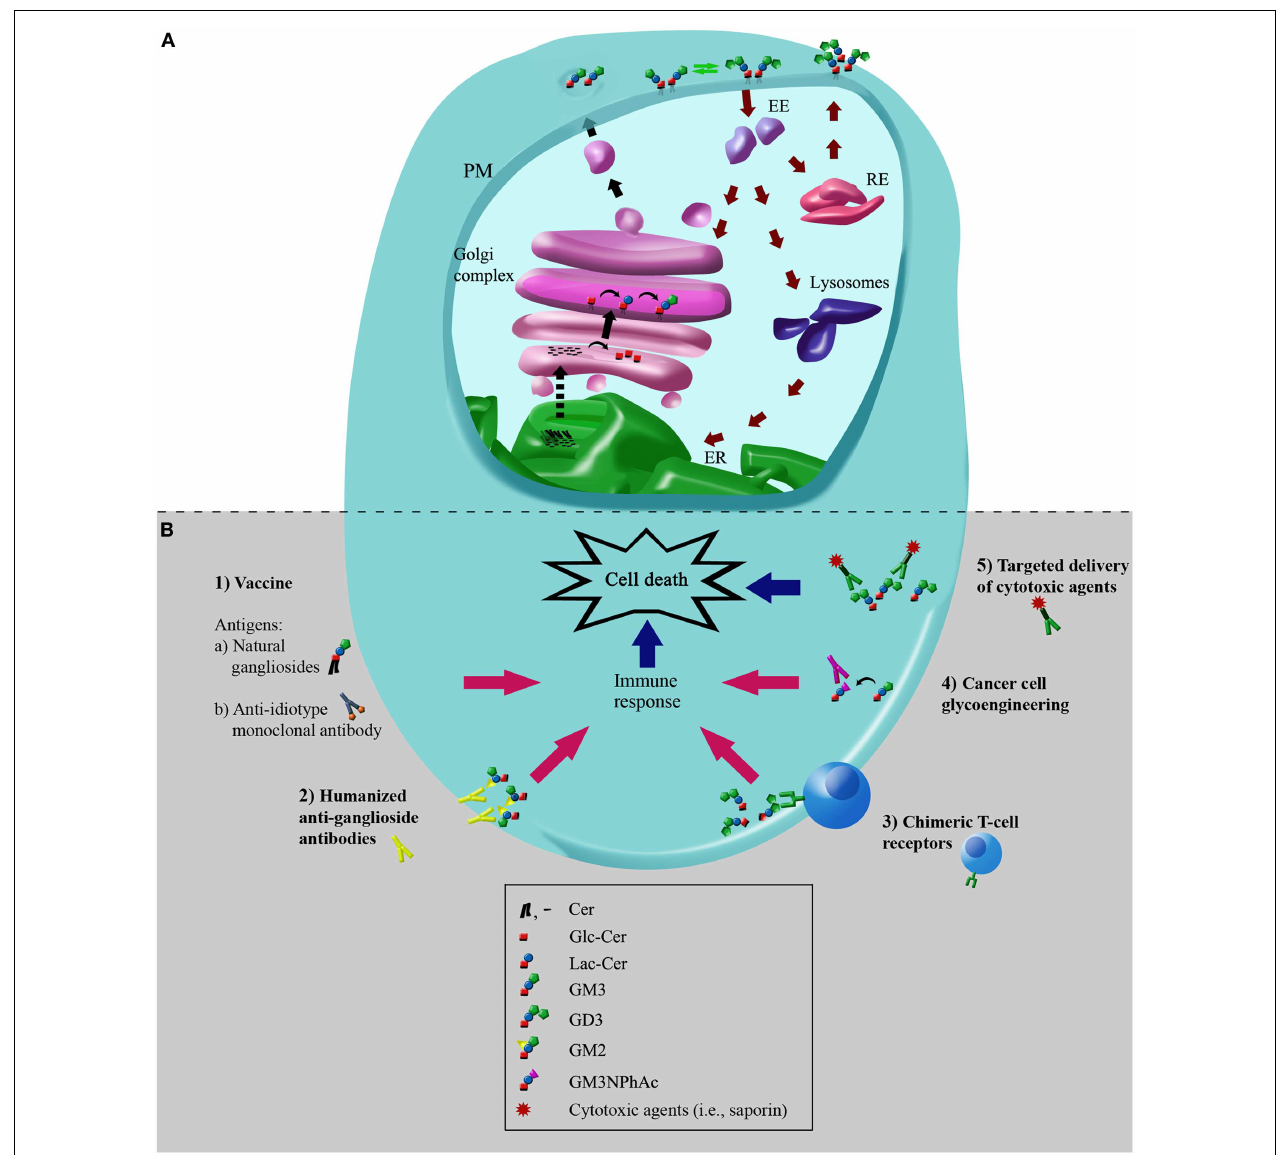
recycled back to the PM directly from recycling endosomes (REs) or sorted from early endosomes (EEs) to the Golgi complex, where they may then be reglycosylated, or transported to the lysosomes for total or partial degradation.The representation and colors of ganglioside structures are the same as in Figure 1 . (B) Potential cancer immunotherapies using gangliosides as molecular targets. Schematic representation depicting the main cancer immunotherapies involving gangliosides: (1) vaccination with natural gangliosides or anti-idiotype monoclonal antibodies; (2) humanized anti-ganglioside antibodies; (3) chimericT-cell receptors; (4) cancer cell glycoengineering and monoclonal antibody-mediated selective killing of cells; (5) targeted delivery of cytotoxic agents using specific antibodies to gangliosides. See text for more details.The schematic representation and colors of gangliosides structures are the same as those indicated in Figure 1